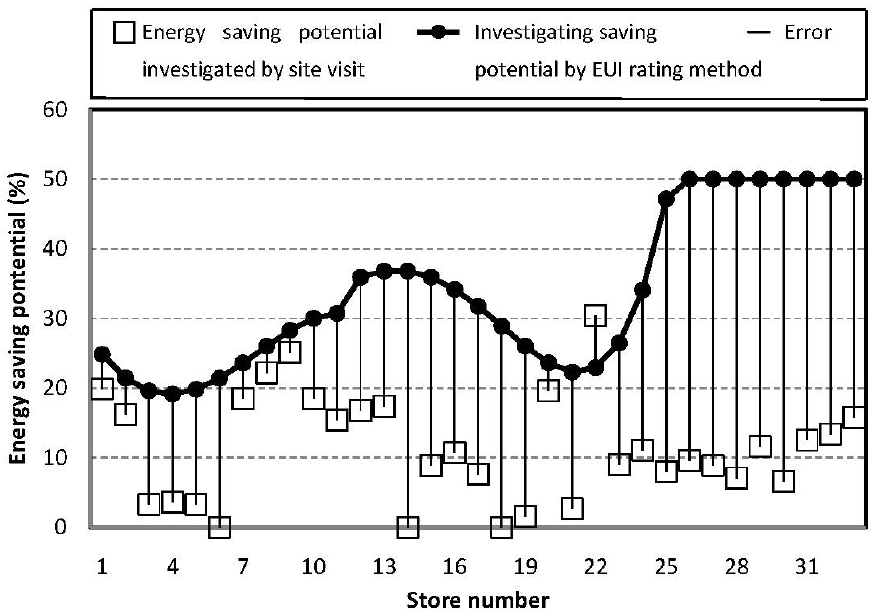
Figure 11. EUI rating method is employed to investigate energy-saving